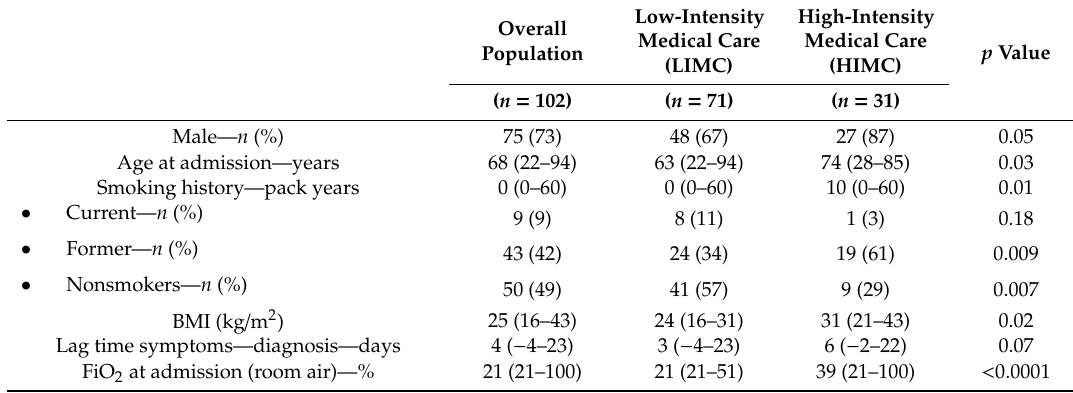
Table 1. Baseline demographics and clinical features of the overall population hospitalized for severe acute respiratory syndrome coronavirus type 2 (SARS-CoV-2) related infection, as well as of the two subgroups categorized in low (LIMC) and high (HIMC) intensity medical